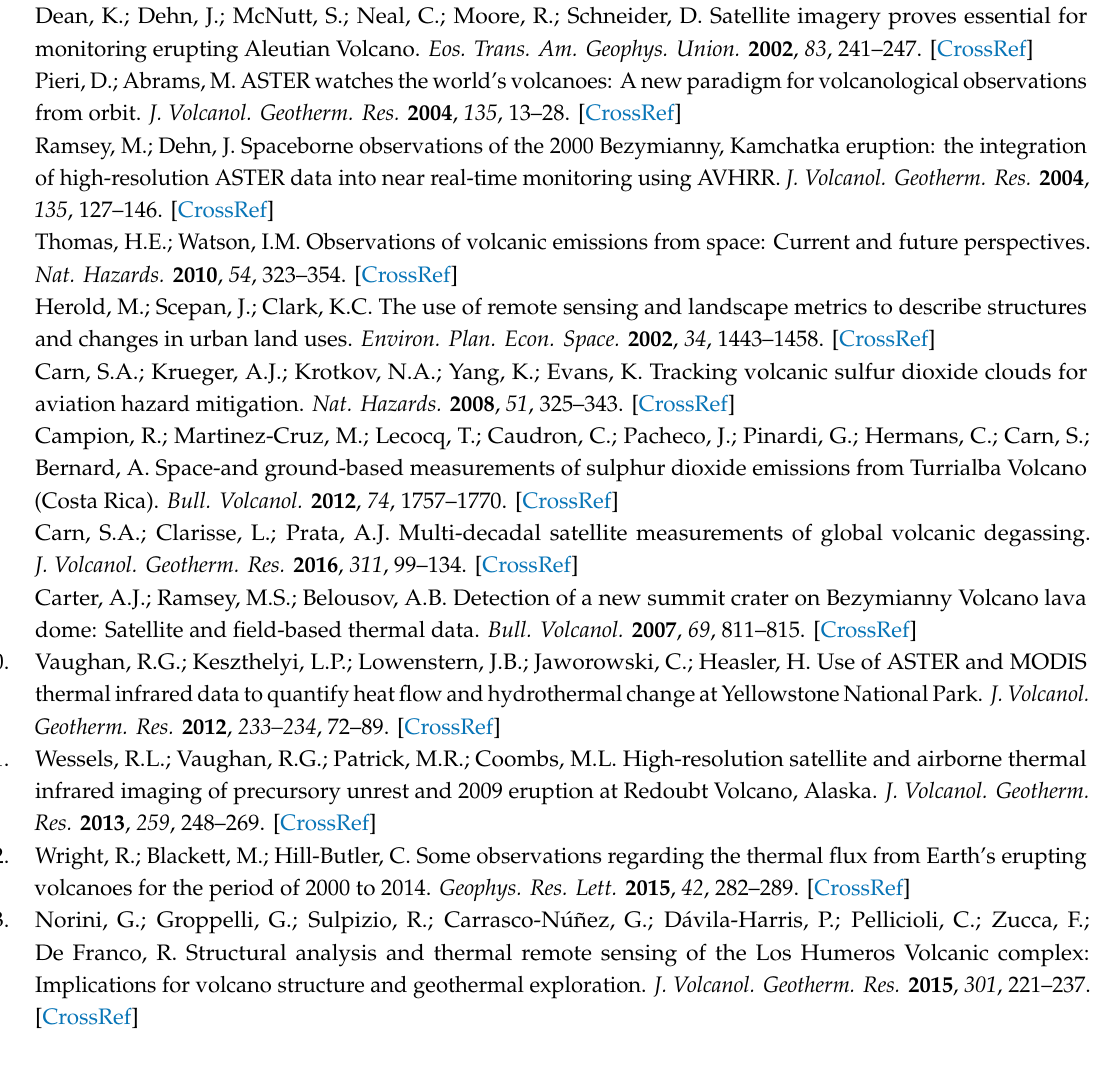
Table S1: Planet Labs imagery timeline data entry for Figure